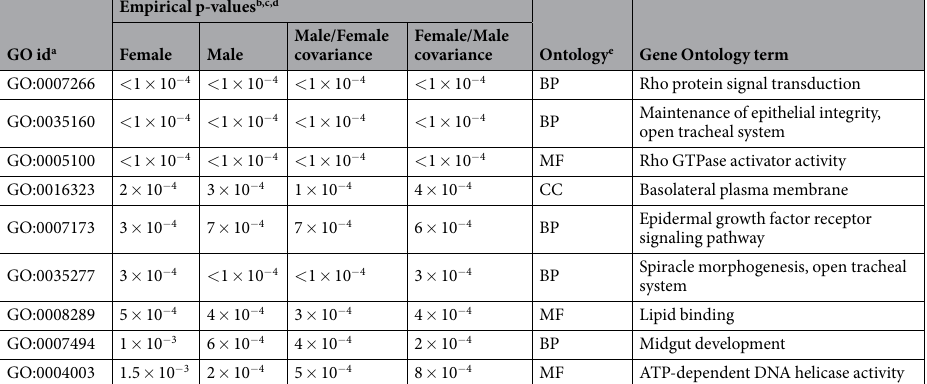
Comparison of set tests. Several GBLUP-derived set tests were compared in terms of statistical power to detect genomic features enriched for causal variants. Despite GBLUP being considered a “black box” mod- eling approach we showed that it is possible to derive powerful set tests from it. In particular, in all scenarios evaluated we showed that the covariance association test (CVAT) had similar power to a commonly used score based approach 28 (also known as the sequence kernel association test, SKAT), and that both CVAT and SKAT